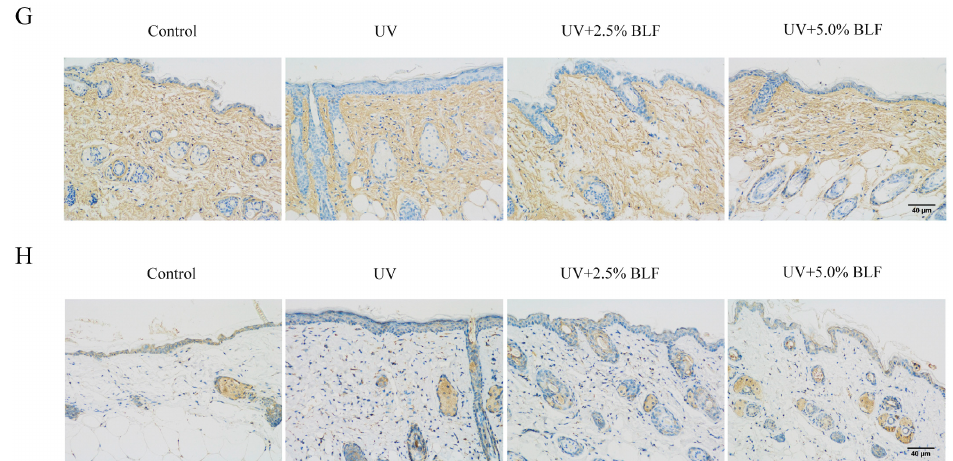
Figure 7. BLF delayed UVB-induced dorsal skin aging in mice. ( A ) Skin hydration analysis. ( B ) Su- peroxide dismutase determined by a total SOD assay kit with WST-8 and detected by a microplate reader. ( C ) Glutathione peroxidase determined by a cellular glutathione peroxidase assay kit with NADPH. ( D ) Catalase determined by a catalase assay kit. * p < 0.05, ** p < 0.01 vs. UV group. ( E ) Epidermal thickness was observed by H&E staining. ( F ) Collagen fibers were stained by Masson staining. ( G ) Type I collagen protein level in skin tissue was detected by immunohistochemistry.